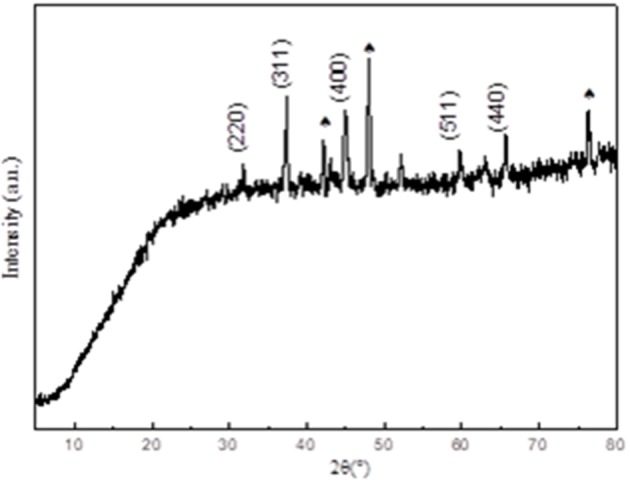
XRD patterns of Co1.